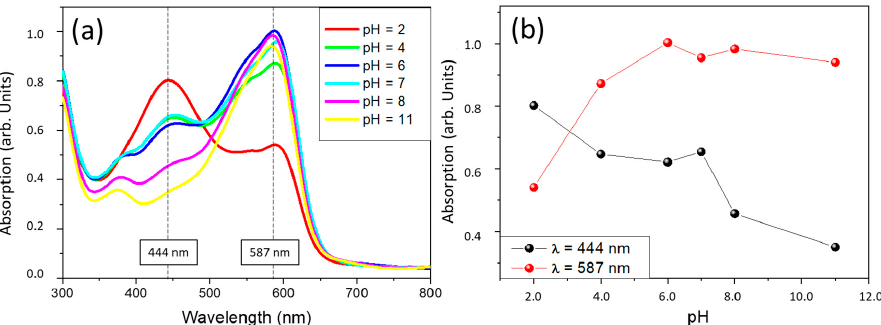
Figure 1. VIS absorption spectra of sample CR on glass substrate at different pHs ( a ). Evolution of maximum absorption spectra at 444 and 587 nm ( b ).